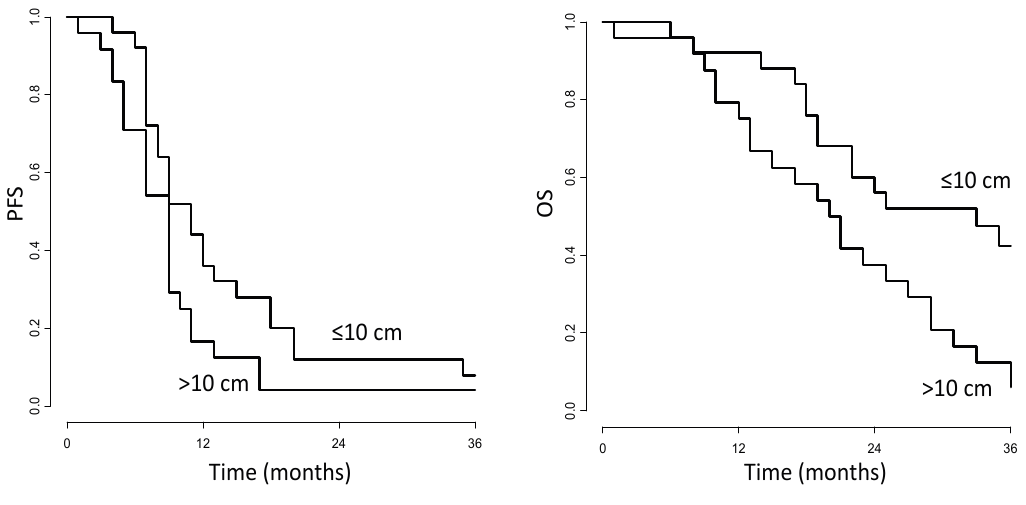
Figure 1. Kaplan-Meier progression-free survival (PFS, left panel) and overall survival curves (OS, right panel) according to disease extension (sum of the longest diameters of target lesions ≤ 10 or >10 cm, respectively) in patients treated with bevacizumab containing